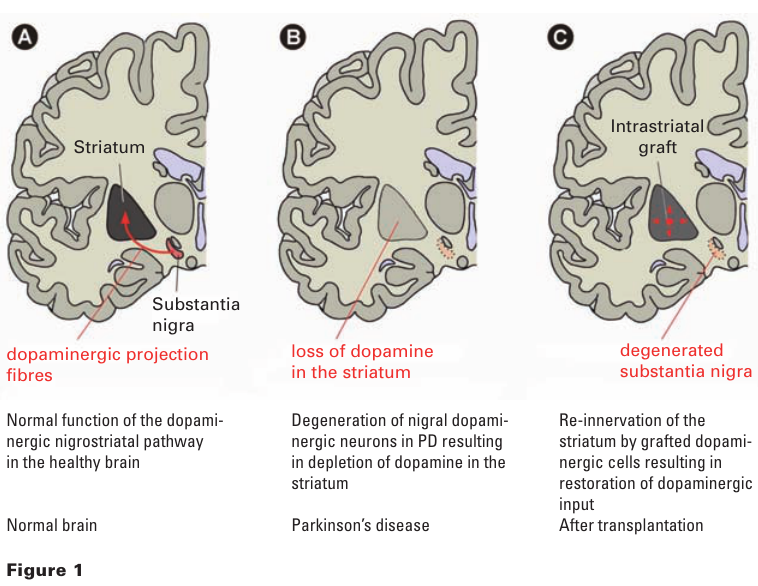
Schematic drawing of transplantation of dopaminergic cells in a patient suffering from Parkinson’s disease (PD). In the healthy brain, dopaminergic input to the striatum is provided by the nigrostriatal projection system (A). In PD, degeneration of the dopaminergic neurons in the substantia nigra leads to dopamine depletion in the striatum and thus dysfunction of the extrapyramidal system (B). After intrastriatal transplantation of dopaminergic neuronal precursor cells, these differentiate into neurons, establish functional connections to the surrounding striatal cells and restore the dopaminergic input to the striatum (C).